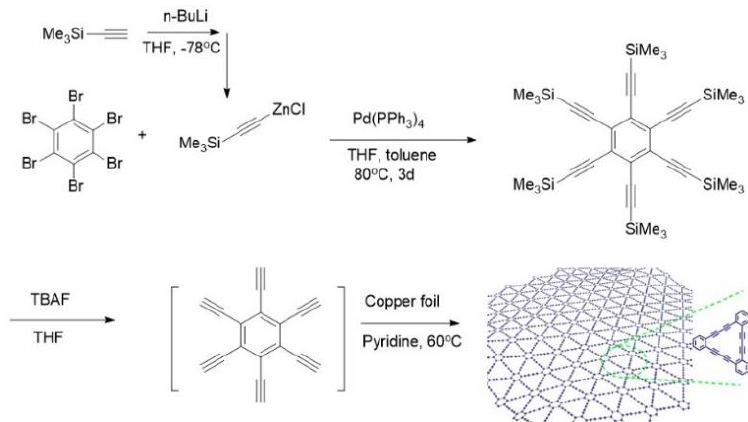
Figure 7. Preparation of graphdiyne (GD) film.